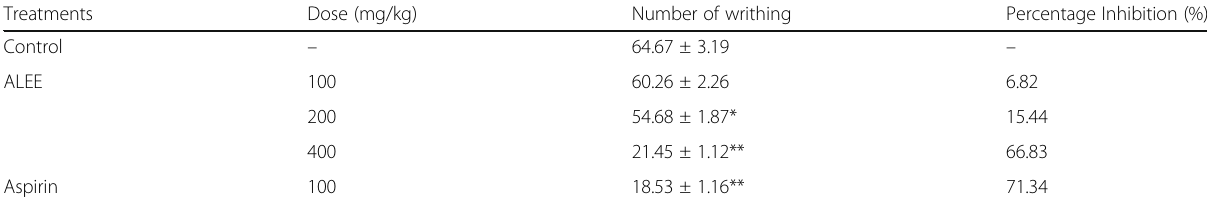
Table 1 Analgesic effect of ALEE on acetic acid-induced writhing in rats Treatments Control